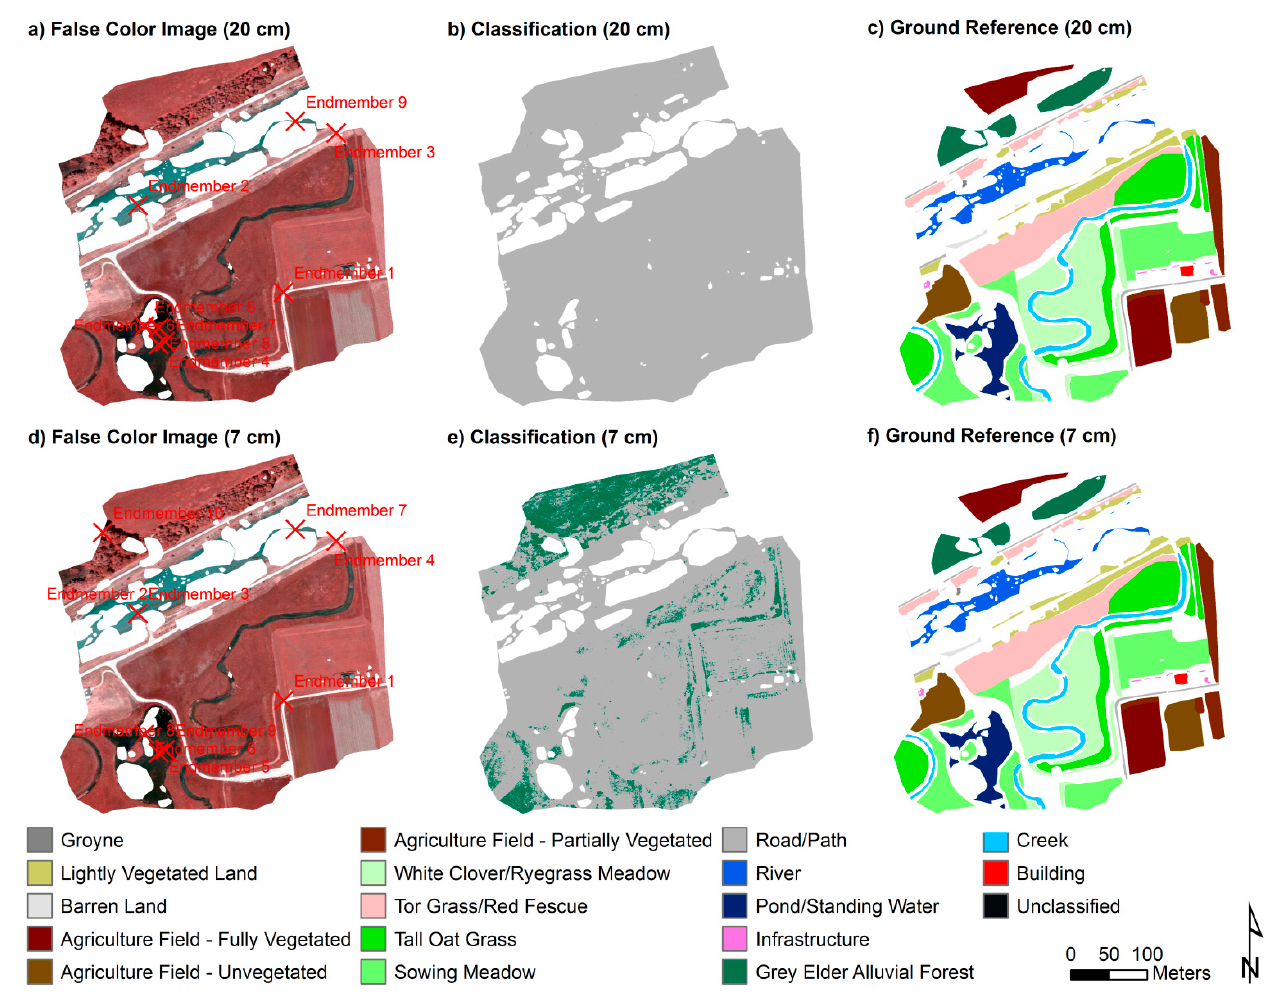
Figure 12. ( a ) Narrow-band image from 22 June 2016 of the River Gail study area with extreme/erroneous pixels masked out at the 20 cm pixel size. The map also shows locations of the identified purest pixels extracted as endmembers and used in the classification; ( b ) Land cover classification generated using the 20 cm narrow-band image, endmembers extracted from ( a ), and the Spectral Angle Mapper algorithm within ENVI; ( c ) Reference data used in assessing the accuracy of the classified image in ( b ); ( d ) Narrow-band image from 22 June 2016 of the River Gail study area with extreme/erroneous pixels masked out at the 7 cm pixel size. The map also shows locations of the identified purest pixels extracted as endmembers and used in the classification; e ) Land cover classification generated using the 7 cm narrow-band image, endmembers extracted from ( d ), and the Spectral Angle Mapper algorithm; ( f ) Reference data used in assessing the accuracy of the classified image in ( e ).